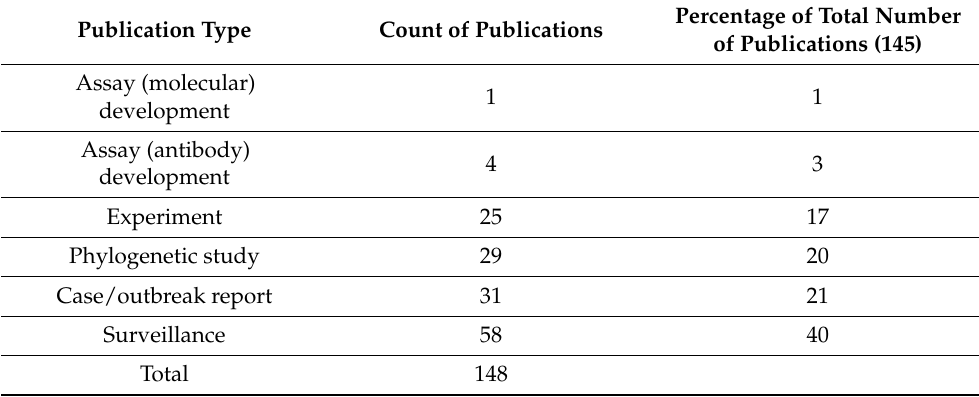
Table 1. The proportion of different types of publications reporting on viruses/viral diseases in African ungulates.